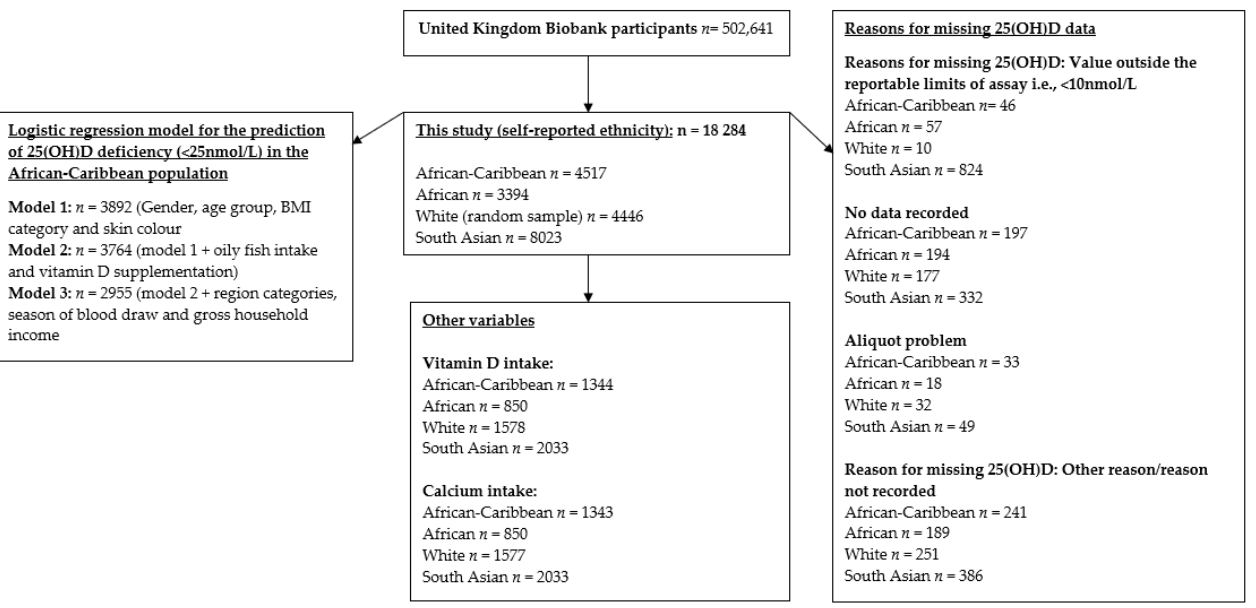
Figure 1. Flow chart of the UK Biobank participants included in the